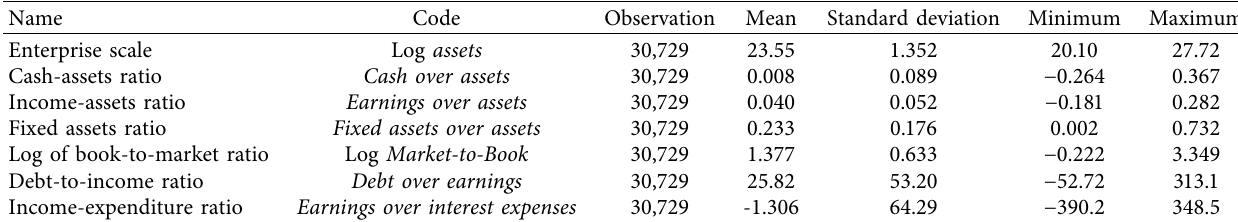
Table 2: Descriptive statistics on control variables.